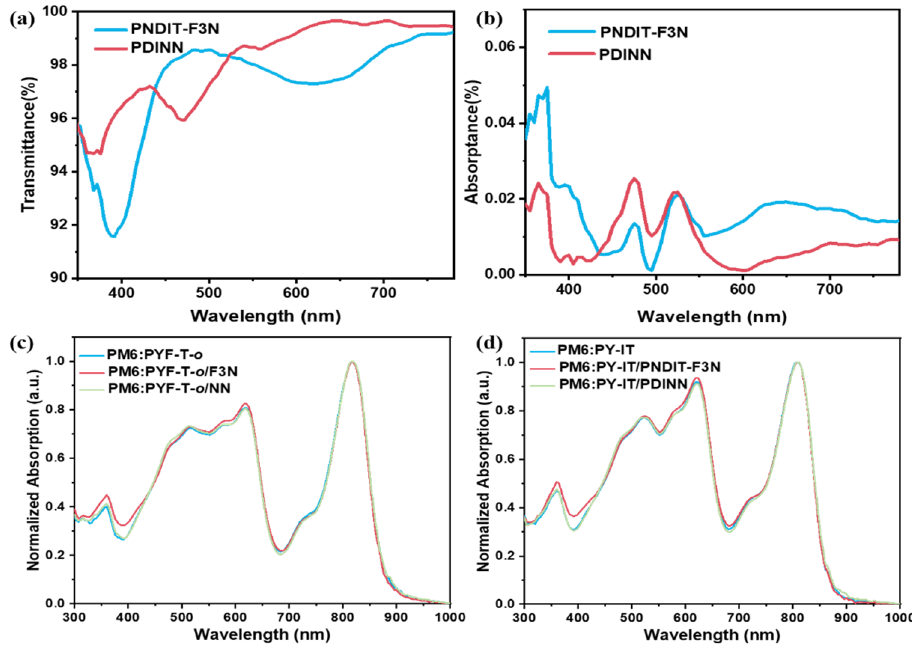
Figure 3. ( a ) UV-Vis transmittance spectra of PNDIT-F3N and PDINN. ( b ) UV-Vis absorption spectra of PNDIT-F3N and PDINN. ( c , d ) Absorption spectra of the active layers based on PYF-T- o and PY-IT, respectively.